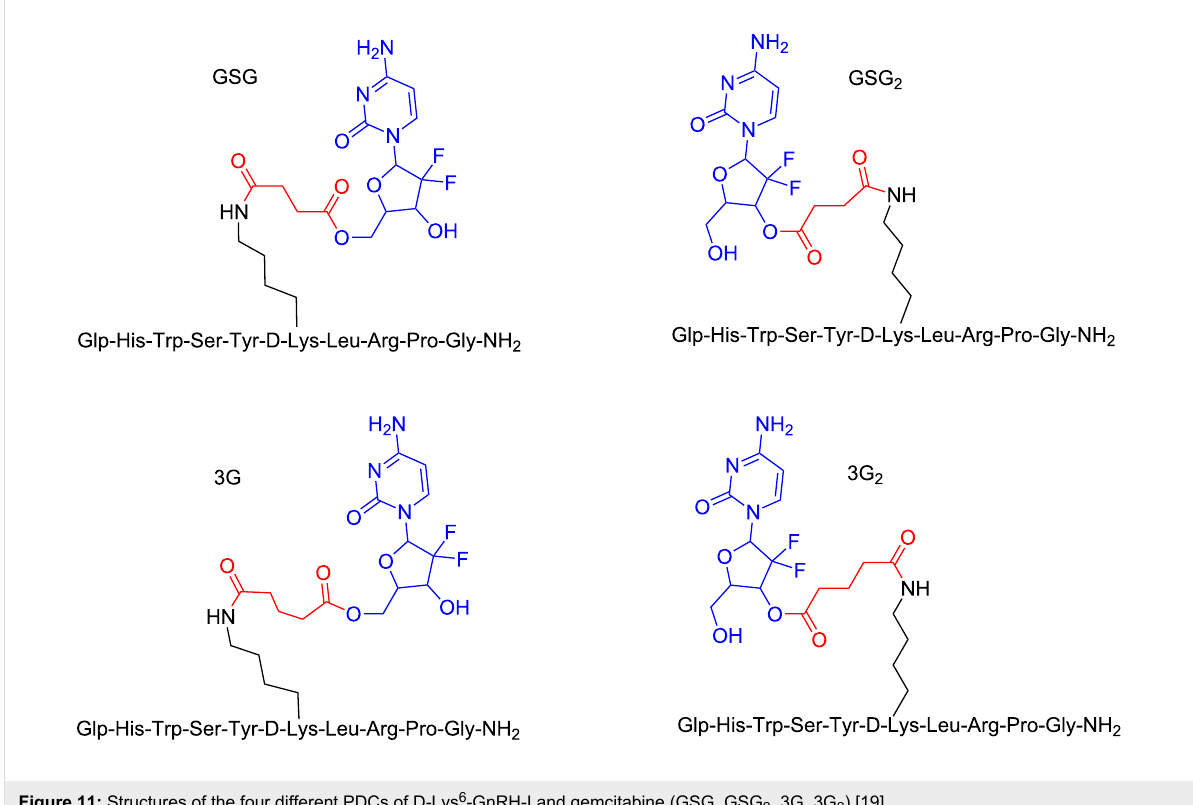
Figure 11: Structures of the four different PDCs of D-Lys 6 -GnRH-I and gemcitabine (GSG, GSG 2 , 3G, 3G 2 ) [19].